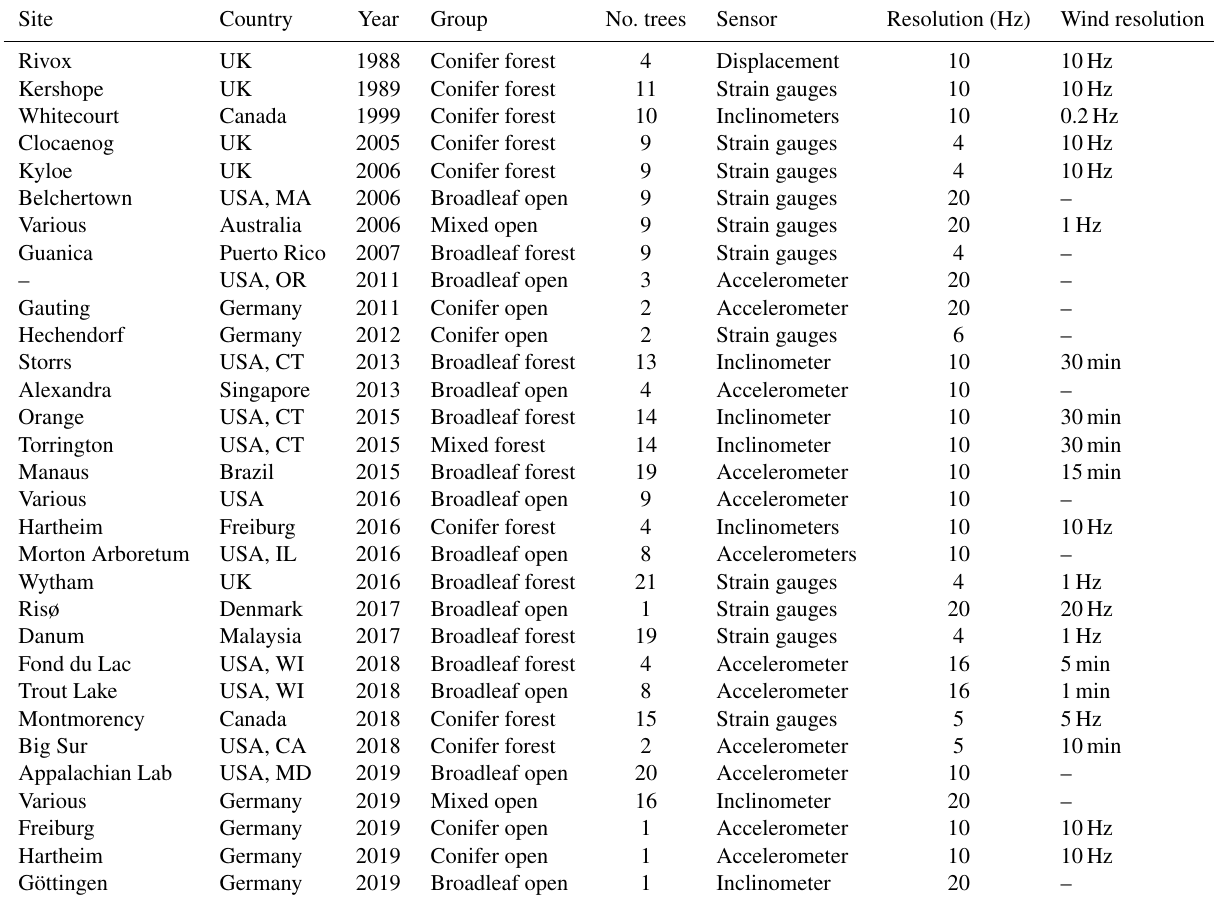
Table 1. Overview of the data sets used in this study. Links to download the data sets are provided in the “Data availability” section.